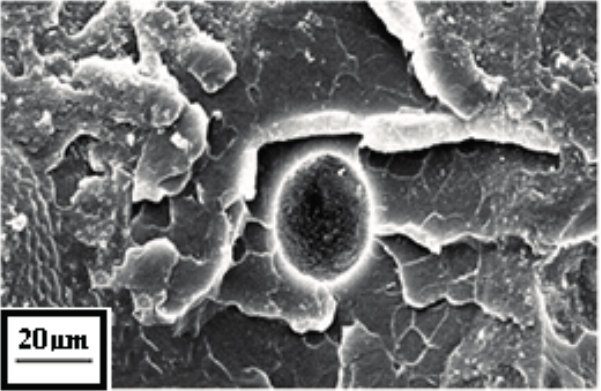
Figure 5. SEM micrograph of fracture zone in